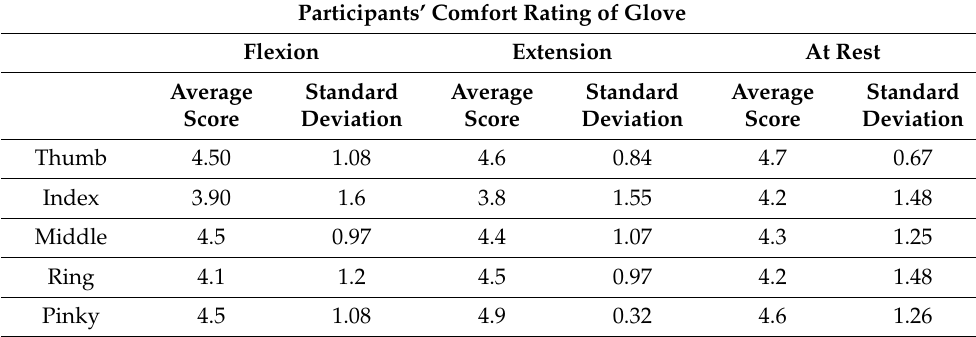
Table 6. Averaged survey results of subjects when asked to rate the pneumatic glove on comfort level where 5 is the most comfortable and 1 is the